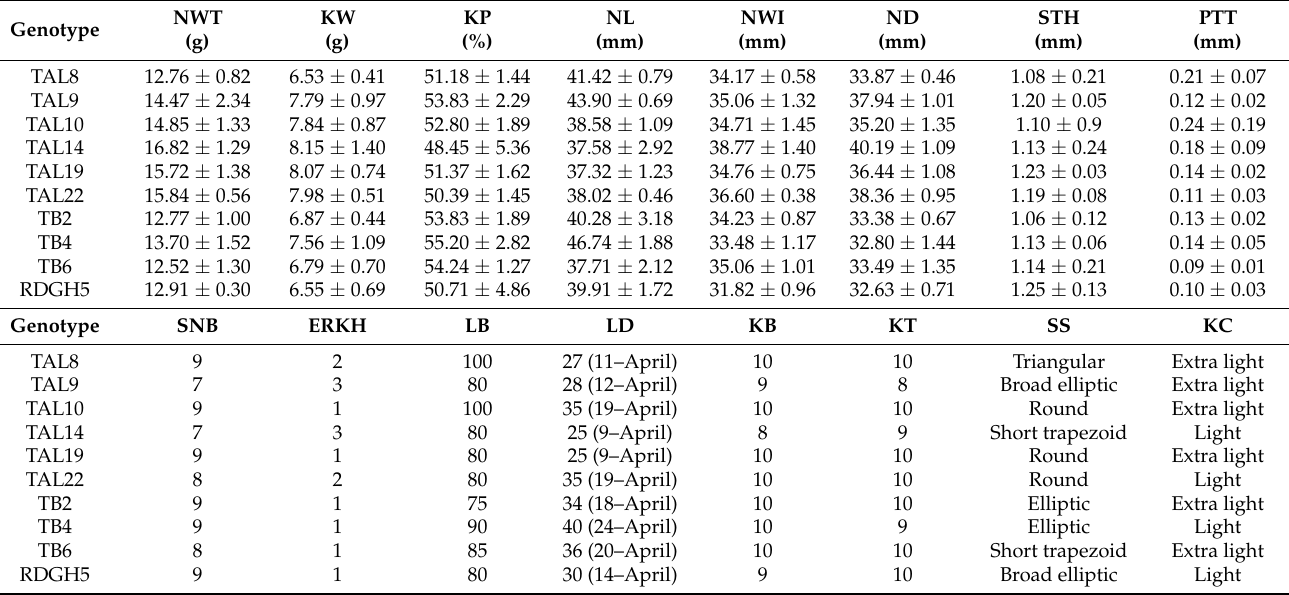
Table 4. Average pomological traits ( ± SE) from 10 superior walnut genotypes in 2018 and